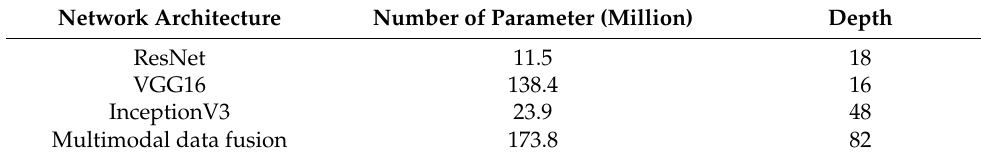
Table 1. The properties of the CNN network architectures and multimodal data fusion. Network